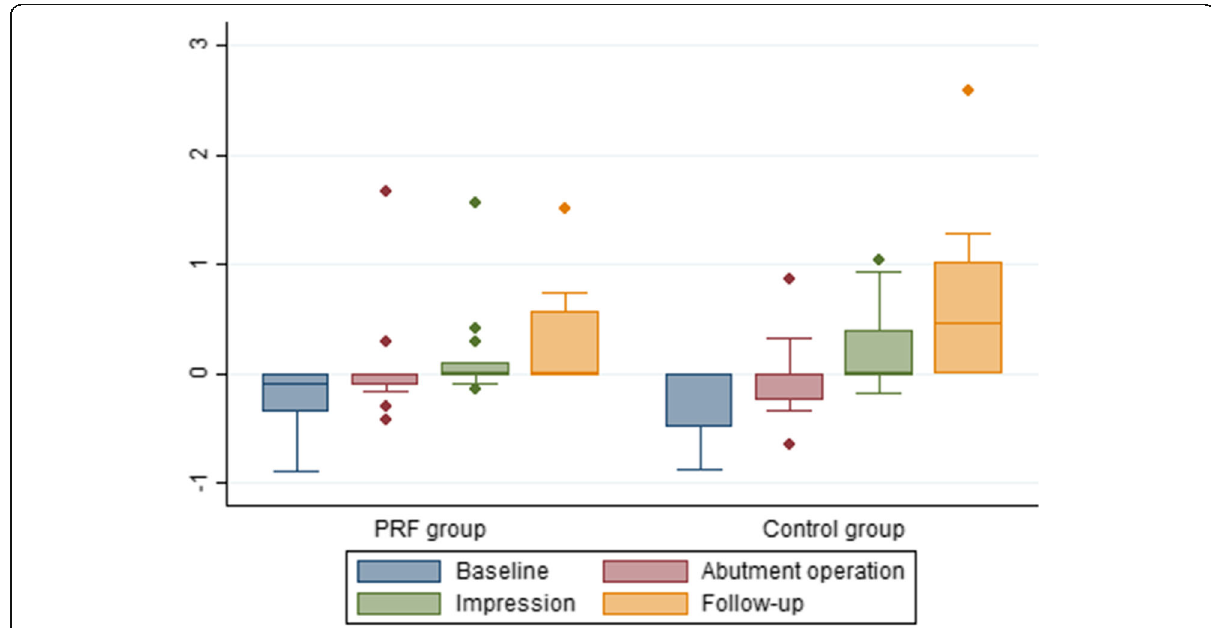
Fig. 2 Box plot of the radiographic peri-implant marginal bone level at different time points in millimeter. Baseline: the time of implant placement; abutment: the time of abutment operation; impression: the time of impression taking; follow-up: the time of the final follow-up